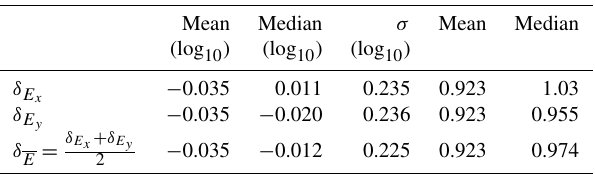
Table 1. Statistical measures of the log 10 of the corrective factors δ E and δ E (i.e. additive in logarithmic domain), as displayed in x y Fig. 8. In addition to the means, medians, and standard deviations of log 10 δ E , the means and medians of δ E (i.e. multiplicative) are is the site-wise mean static shift – i.e. the also shown. Note that δ E mean of δ E and δ E on a site-by-site x y